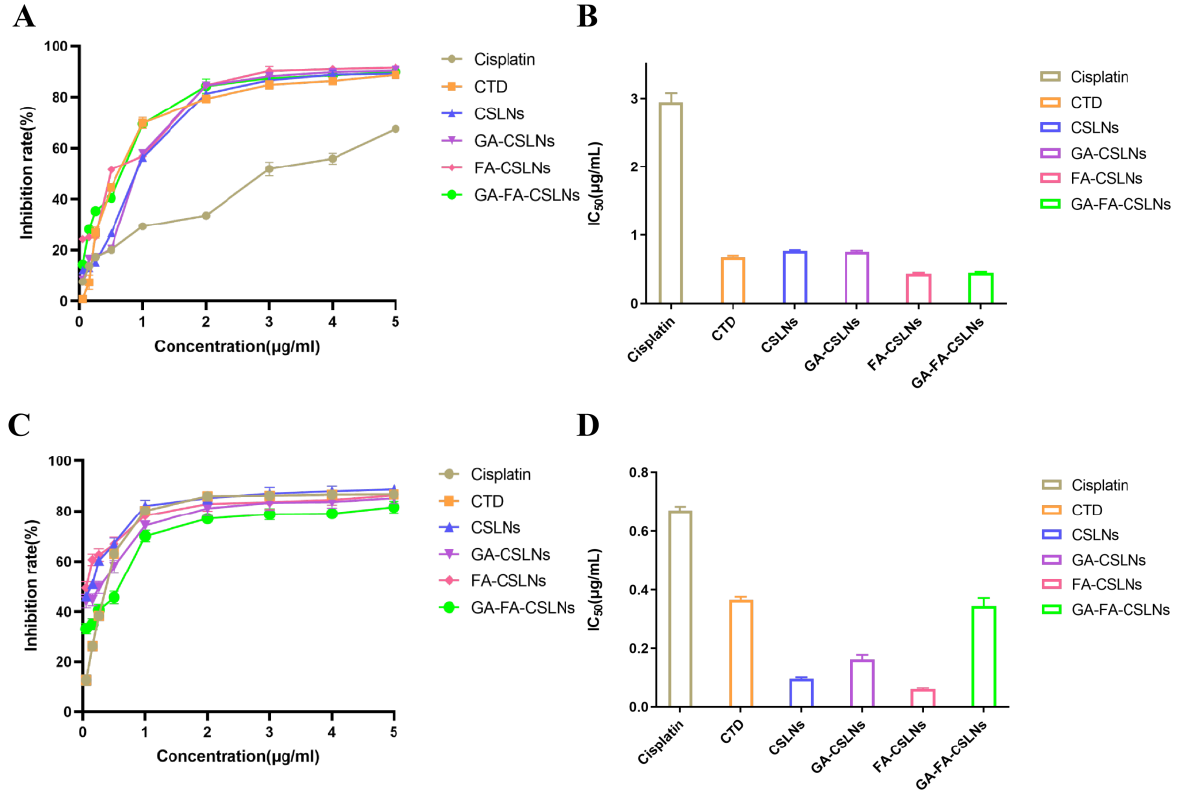
Figure 5. In vitro cytotoxicity of SLNs on HepG2 cells and L-02 cells; ( A ) the inhibition rate of HepG2 cells; ( B ) the values of HepG2 cells IC 50 ; ( C ) the inhibition rate of L-02 cells; ( D ) the values of L-02 cells IC 50 . Date is presented as the mean ± SD ( n = 6).